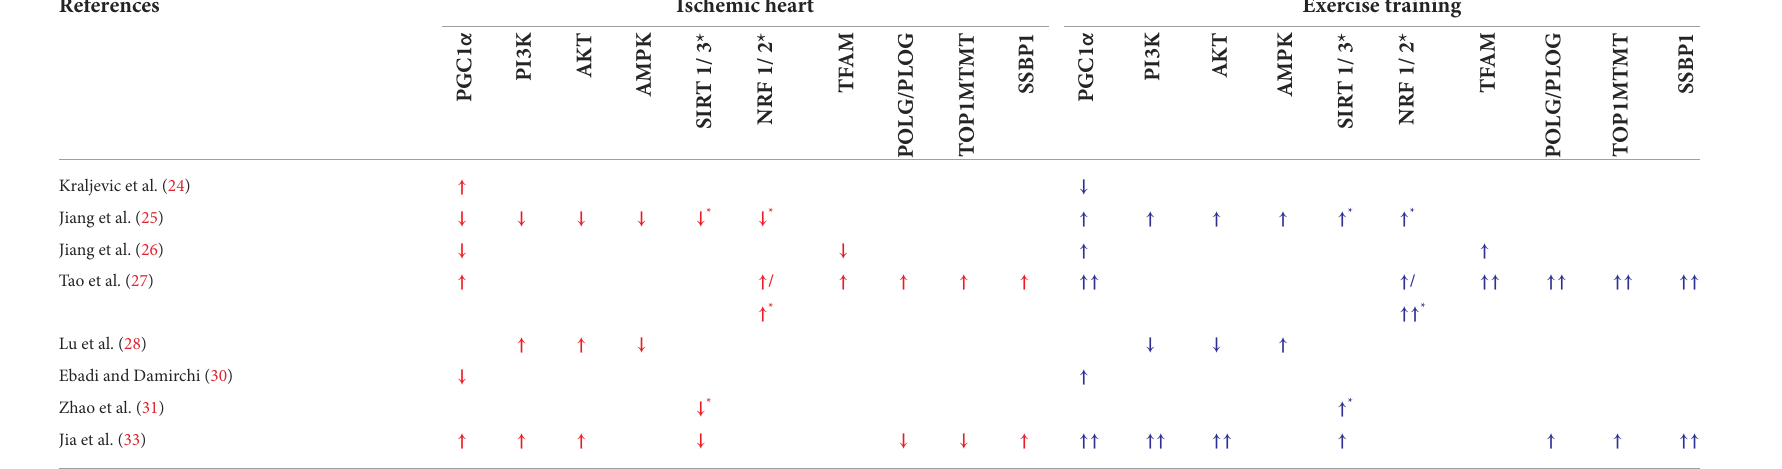
TABLE 4 Effects of ischemia and exercise training on cardiac mitochondrial quality